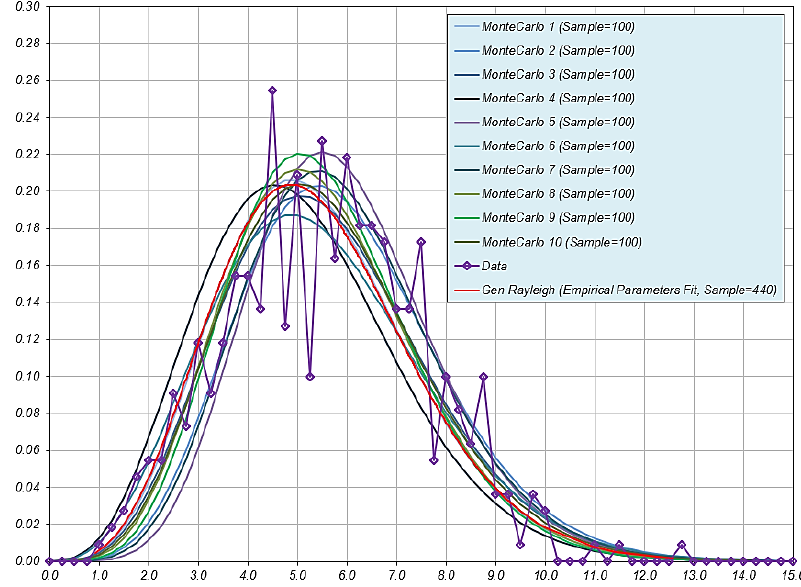
Figure A4. PDF simulated using subsets of sample with Size = 100 .